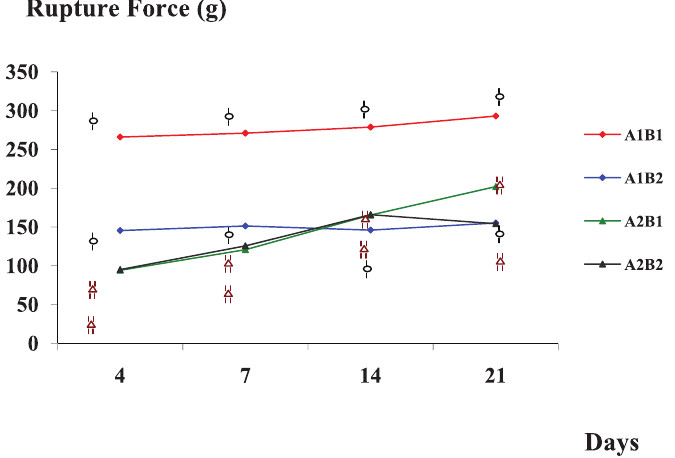
FIGURE 4 - Evolution of mean rupture force in experimental groups: A1 without anti-inflammatory, A2 with anti-inflammatory, B1 without antibiotic, and B2 with